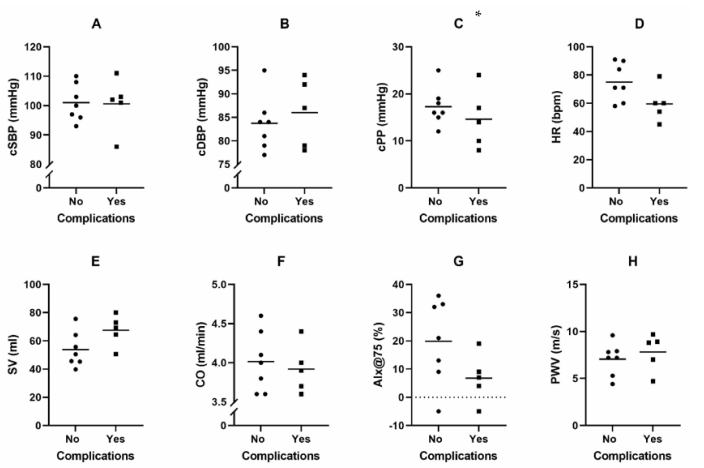
Figure 3. Distribution of non-invasive hemodynamics in HF with an LVAD with and without adverse events ( A – H ). Abbreviations: cSBP, central systolic blood pressure; cDBP, central diastolic blood pressure; cPP, central pulse pressure; HR, heart rate; SV, stroke volume; CO, cardiac output; AIx, augmentation index; PWV, pulse wave velocity. Note: bars represent mean values, dots represent individual patients. * p =